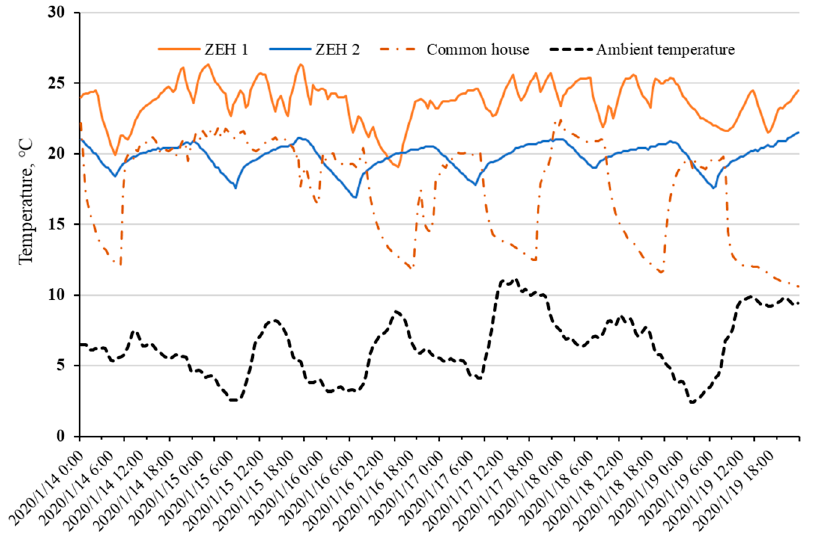
Figure 4. Comparison of measured indoor air temperature profiles among ZEHs, common house